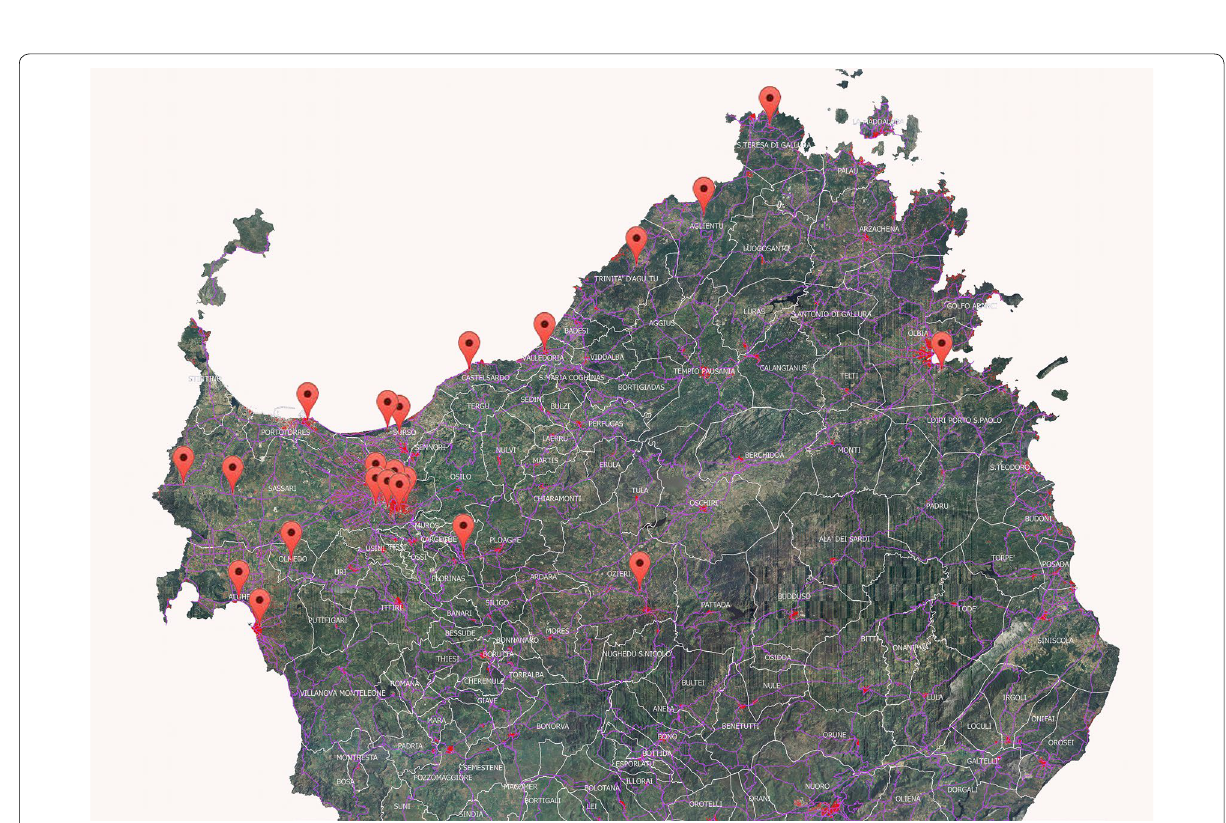
Fig. 1 The sprawl of the “camps” in north Sardinia in 2017 (figure by M. Jendoubi, N.